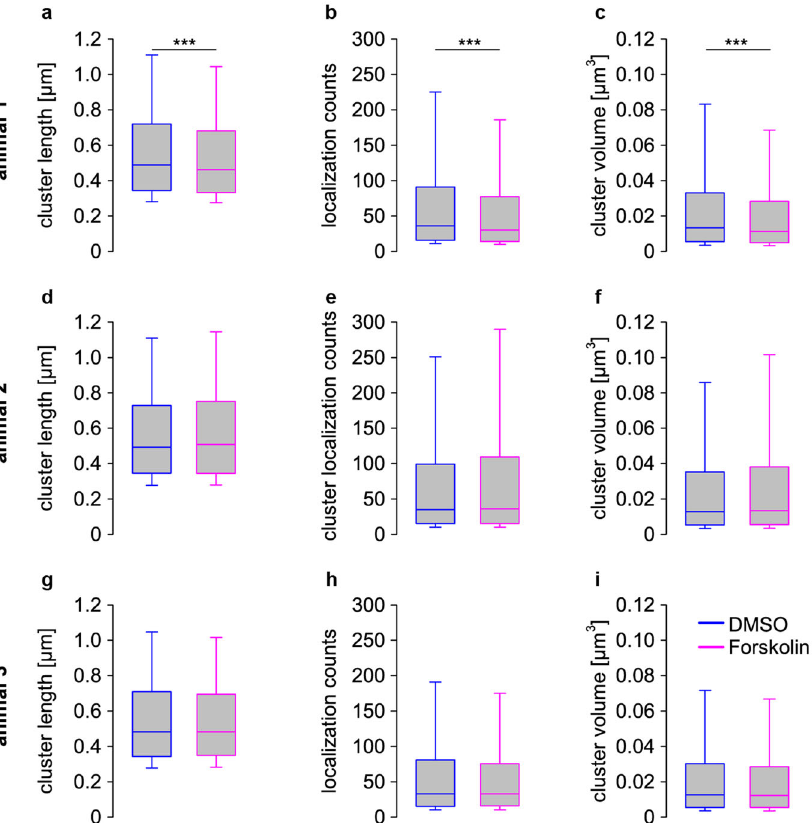
Fig. 5 Forskolin induced plasticity. Bassoon cluster measures in scanning d STORM of 25 µ m cryosections obtained from 300 µ m acute brain sections of hippocampal mouse tissue; control group treated with DMSO (blue) experimental group treated with Forskolin solved in DMSO (magenta). One out of three animals showed highly signi fi cant changes ( p < 0.001) in a Bassoon-cluster length (median ± 25th – 75th percentile; DMSO: 0.490 ± 0.344 – 0.721 µ m; Forskolin: 0.462 ± 0.333 – 0.681 µ m) b localization counts (DMSO: 36 ± 16 – 91; Forskolin: 30 ± 14 – 77) and c volume (DMSO: 0.0132 ± 0.0056 – 0.0331 µ m 3 ; Forskolin: 0.0112 ± 0.0050 – 0.0283 µ m 3 ); Animal 2: d length (DMSO: 0.482 ± 0.343 – 0.709 µ m; Forskolin: 0.482± 0.349 – 0.694 µ m), e counts